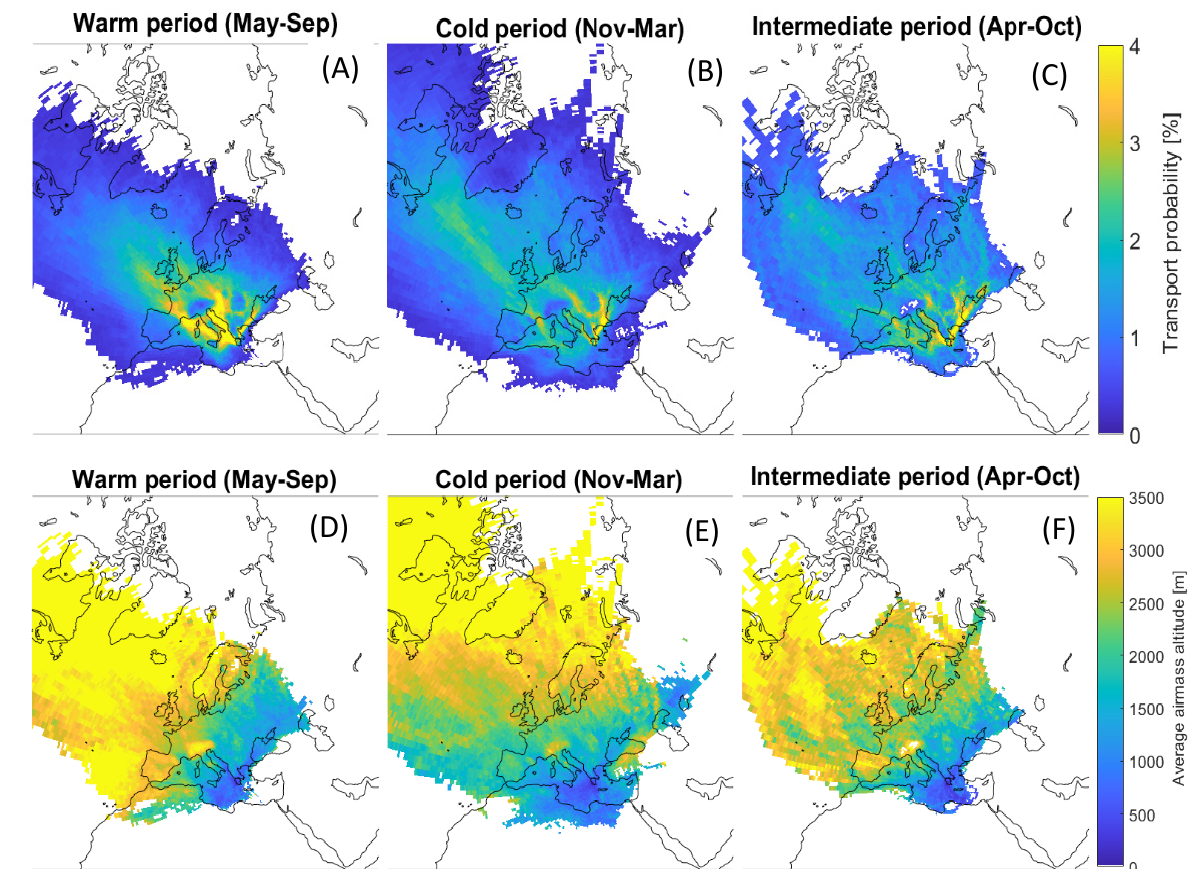
Figure 2. Top panel; Transport source area characteristics, last 240 h, for the warm period, May–September ( A ), cold period November–March ( B ) and transition months April and October ( C ). Bottom panel; Transport average altitude characteristics, last 240 h, for the warm period ( D ), cold period ( E ) and transition months ( F ).